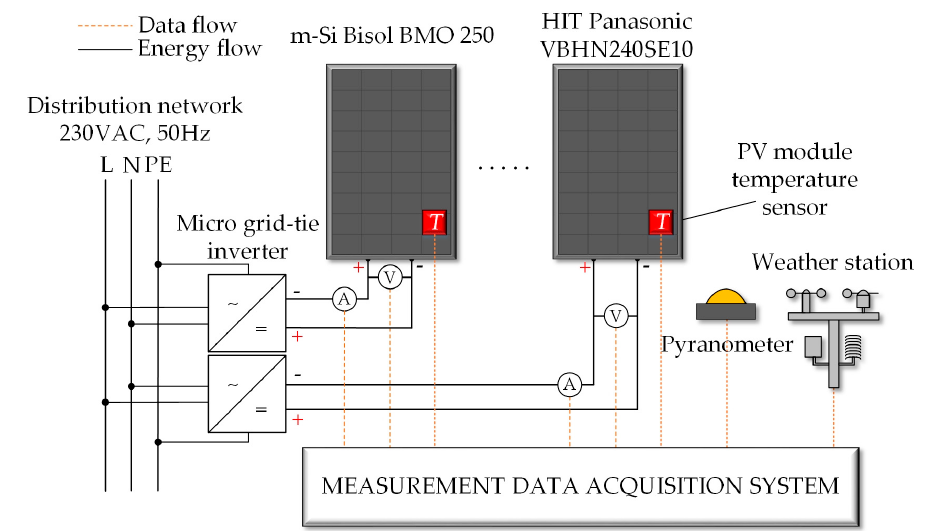
Figure 2. Block diagram of the data acquisition system (DAQ) system.